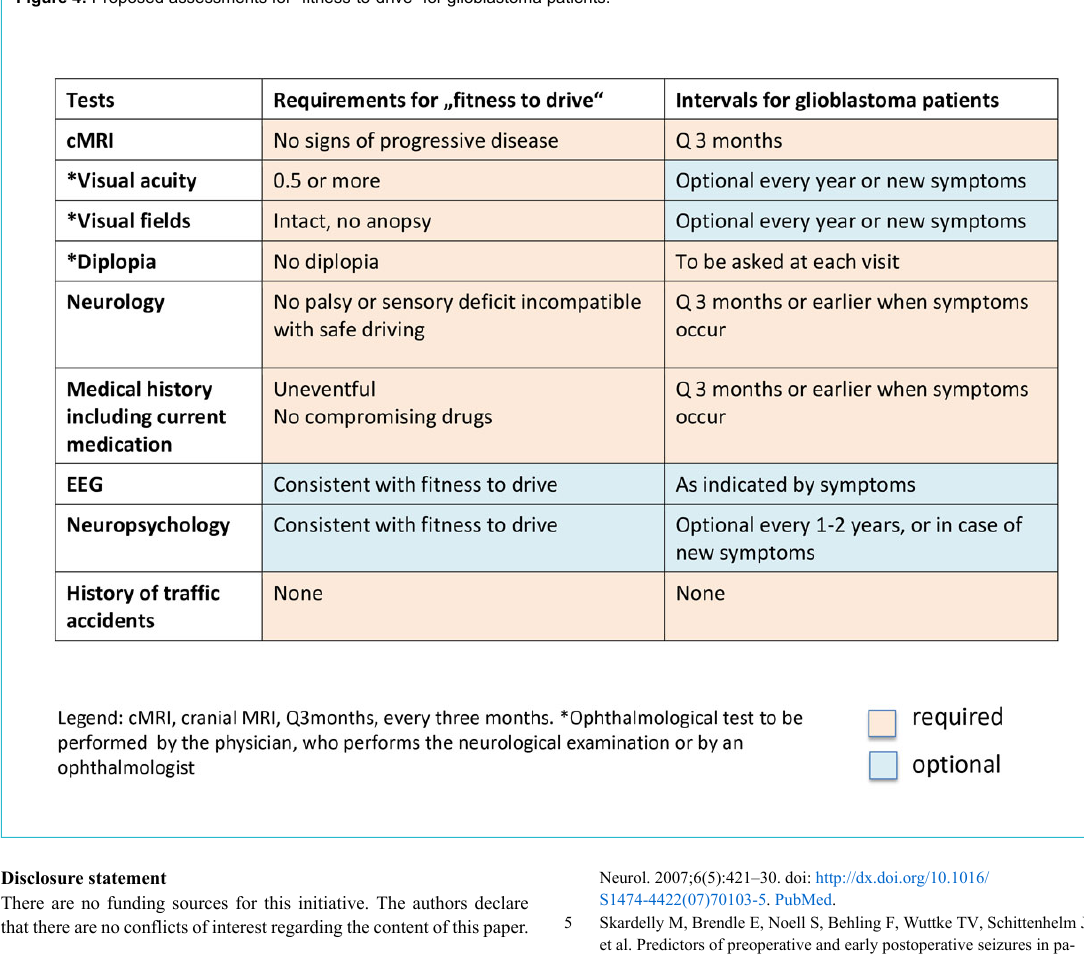
Figure 4: Proposed assessments for “fitness-to-drive” for glioblastoma